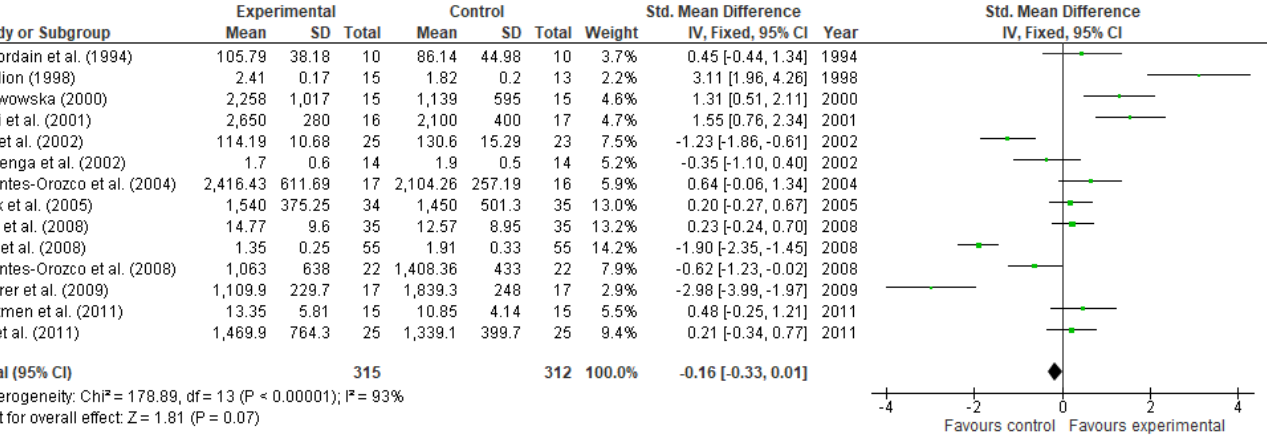
Figure 15. T-cell lymphocytes: fixed-effects meta-analysis and forest plot from studies providing supplementation of glutamine.